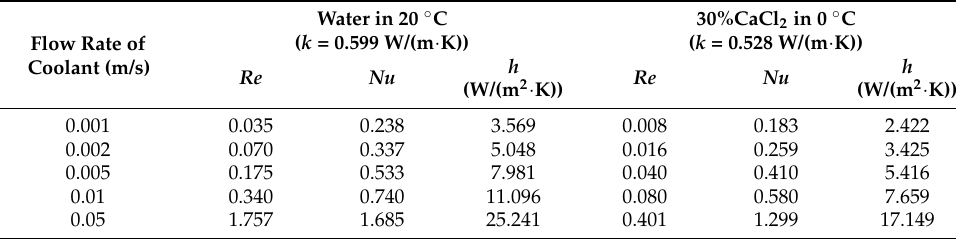
Table 1. Convective coefficients of cooling agents in different conditions.